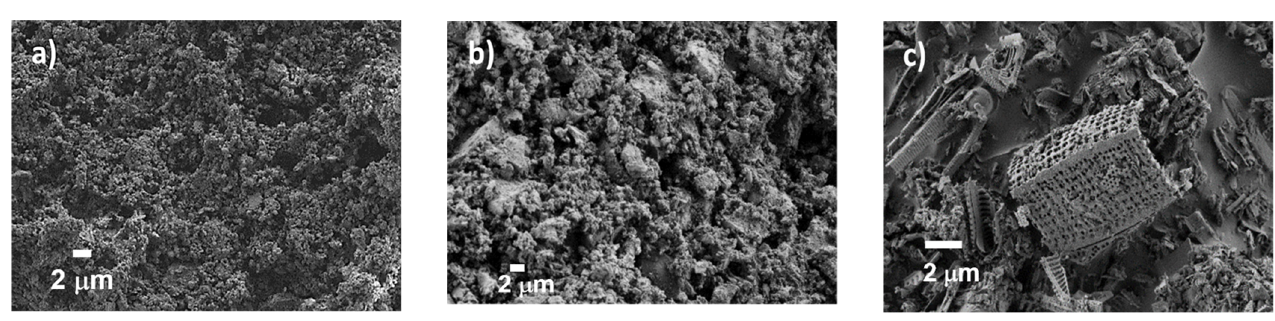
Figure 2. FESEM micrographs of materials: ( a ) FCC; ( b ) RHA; ( c ) RDE. Table 2. Mix proportions of traditional and hybrid